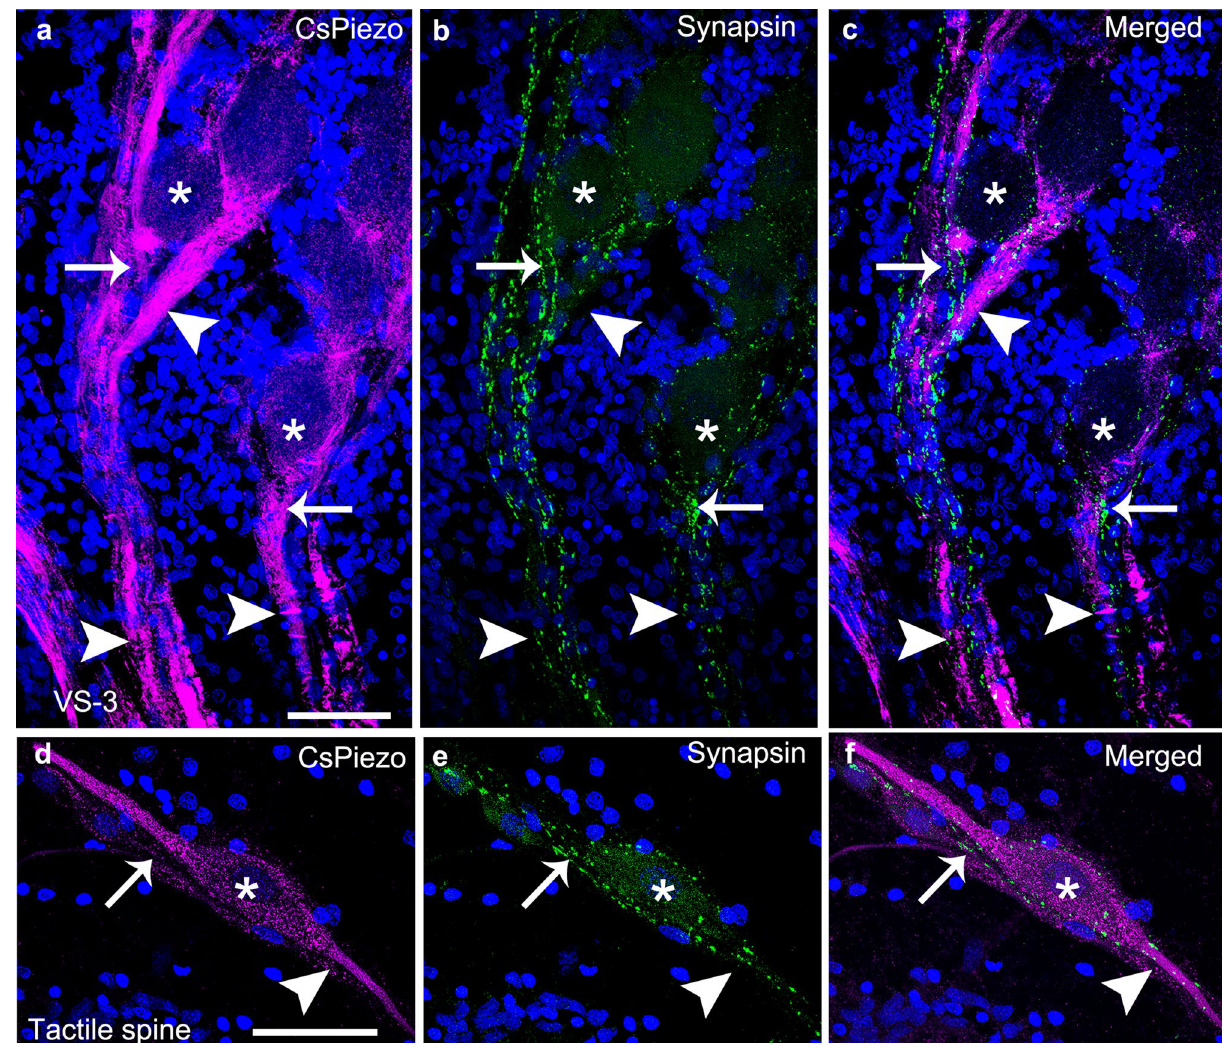
Figure 4. Double labeling with CsPiezo and synapsin antibodies. ( a–c ) The VS-3 neuron axons ( arrowheads ) were strongly labeled by the CsPiezo antibody ( a , magenta ) and the synapsin labeling ( b , green ) was in the fine efferent fibers that surround the axons and cell bodies ( some indicated by asterisks ). The merged image ( c ) shows that synapsin and CsPiezo were not co-localized ( arrows ), although the labeled structures were close to each other. ( d , e ) CsPiezo labeling ( d ) in the dendrites ( arrow ) and axons ( arrowhead ) of three neurons innervating a tactile spine in the spider patella. The three cell bodies ( the largest indicated by an asterisk ) were less strongly labeled. Synapsin labeling ( e ) in the efferent fibers was not co-localized with CsPiezo labeling, as seen in hte merged image ( f ) ( arrow ). Blue DAPI staining is in the nuclei of all cells of the hypodermis. Scale bars are 50